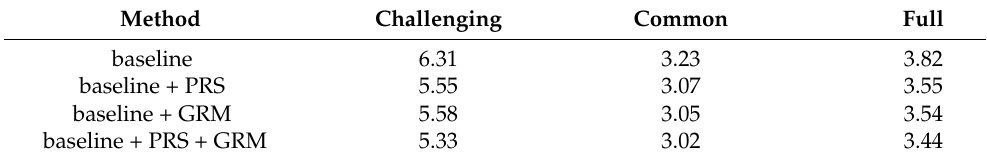
Table 6. Ablation experiments of the patch resampling stage (PRS) and the group-relational module